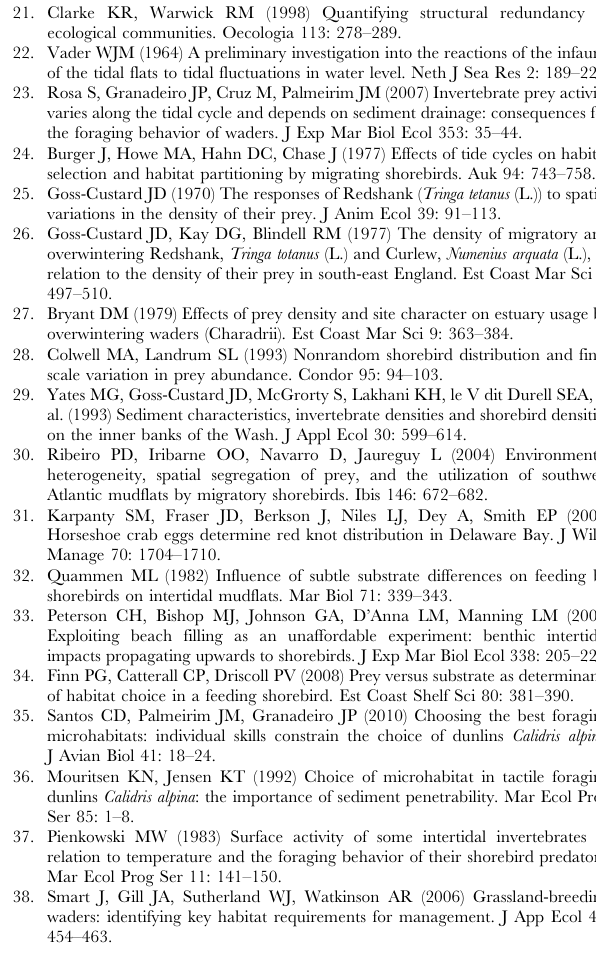
Table S9 Results of post hoc pairwise comparisions of flats following Analysis of Similarity (ANOSIM) on benthic invertebrate community composition dataset of abundances by species (or genus, and in some cases higher taxon). Table S10 Results of Tukey-Kramer HSD post hoc comparisons of all possible pairs of flats based on percentage composition of each size class of